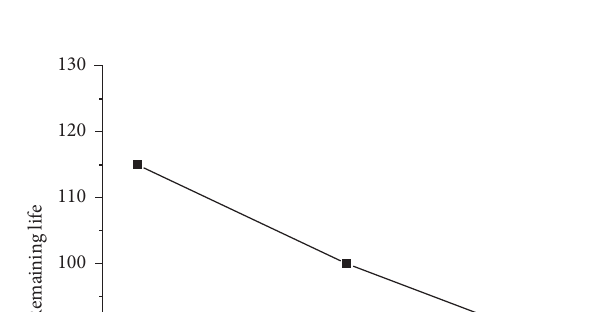
Figure 11: Influence of coefficients of variation of